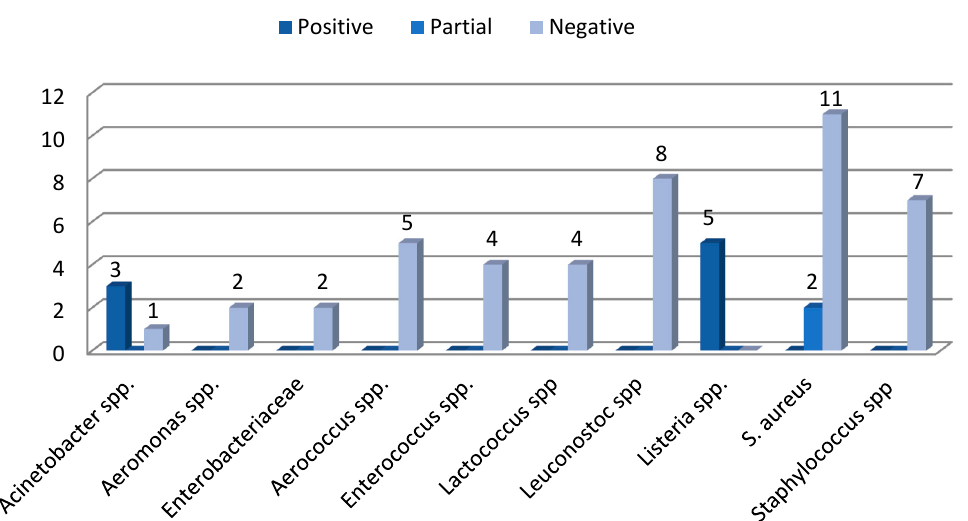
Figure 3. Haemolysis test results.